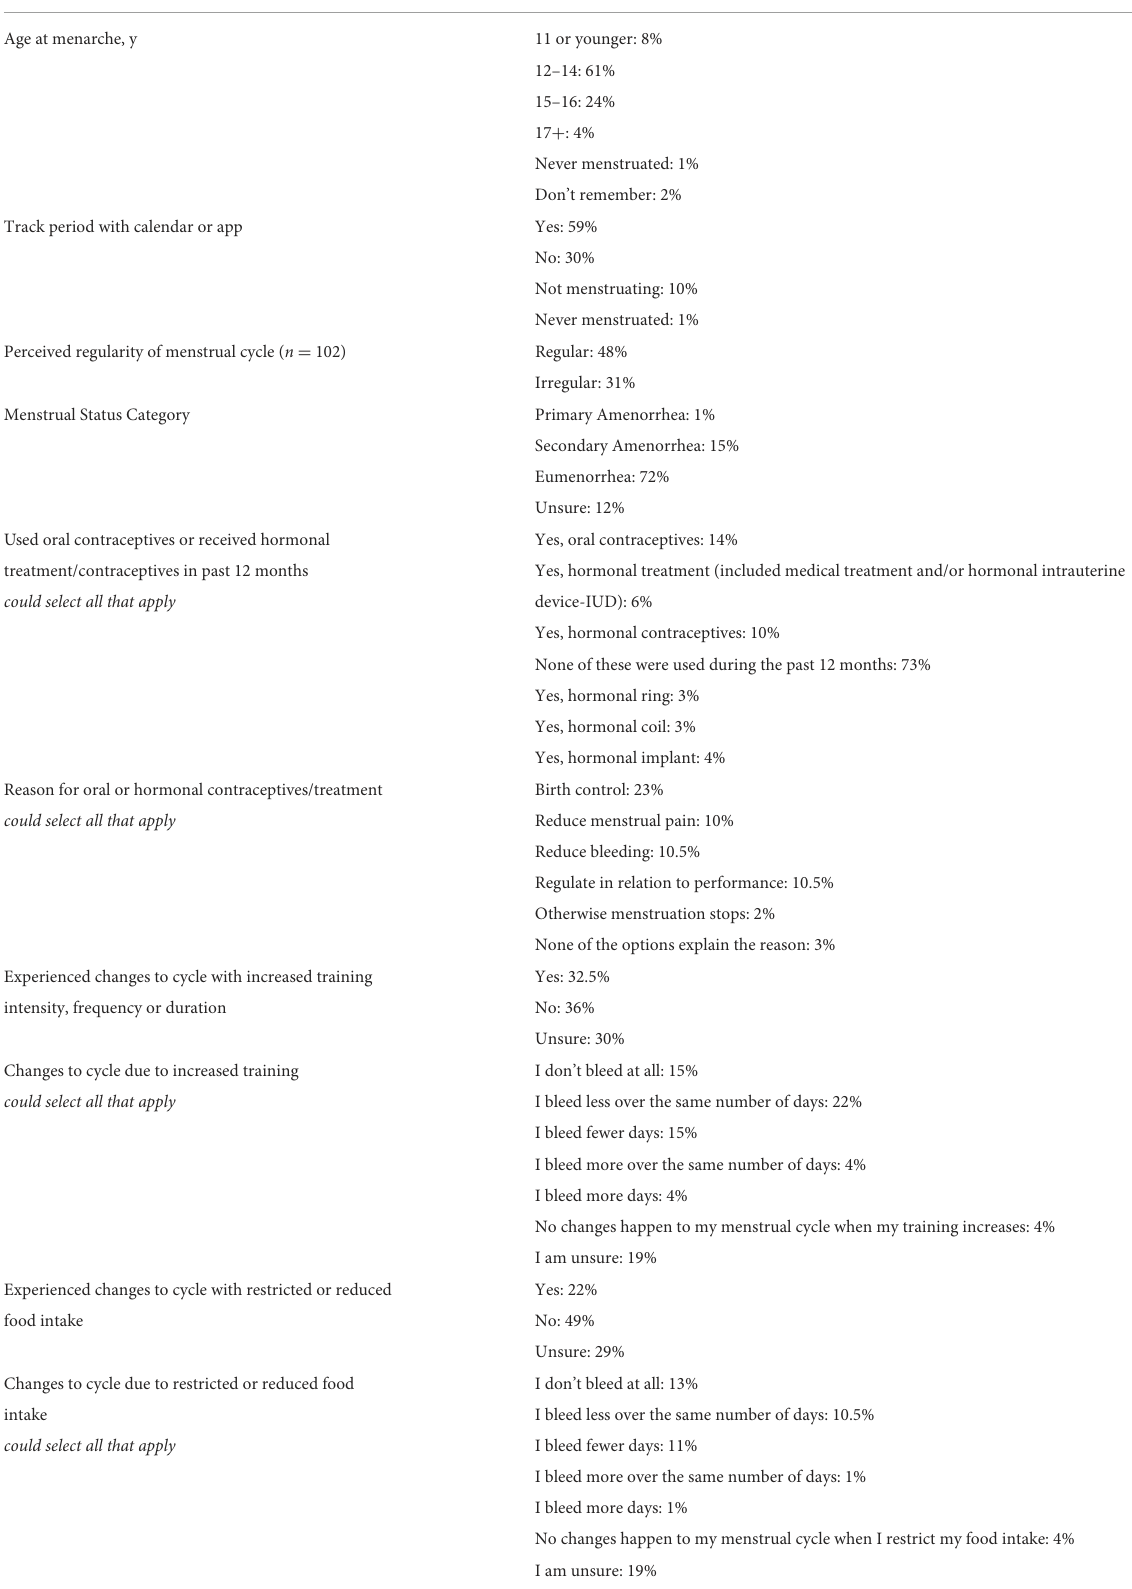
TABLE 4 Menstrual cycle